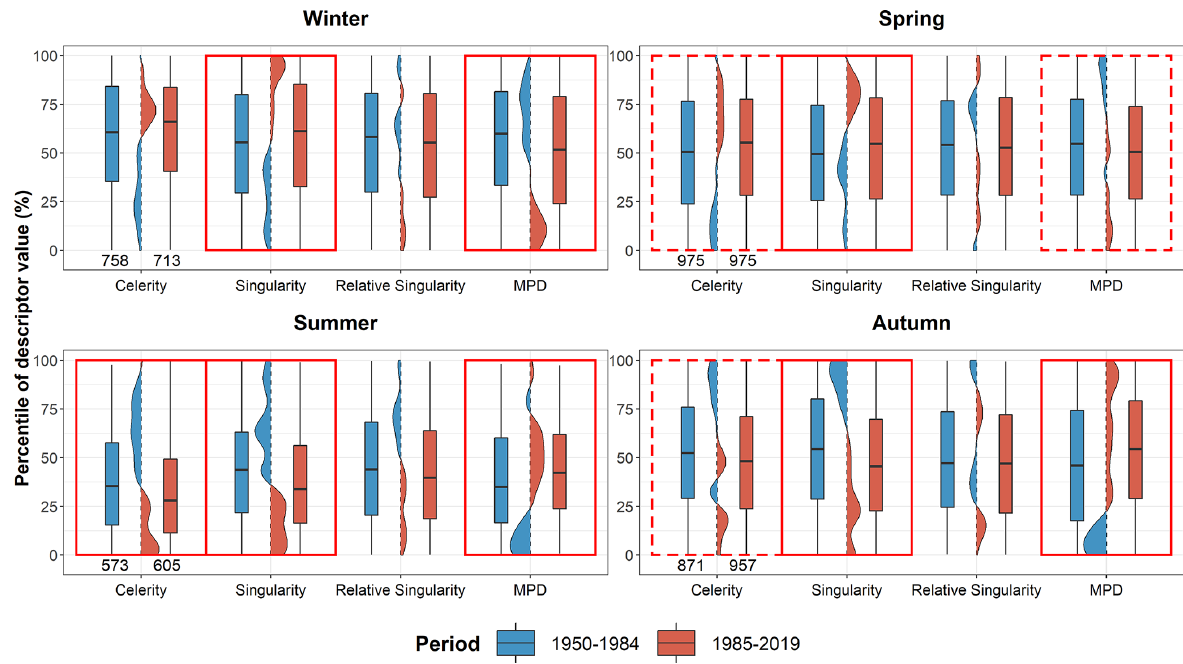
Figure 8. Same as Fig. 6 but for Mediterranean